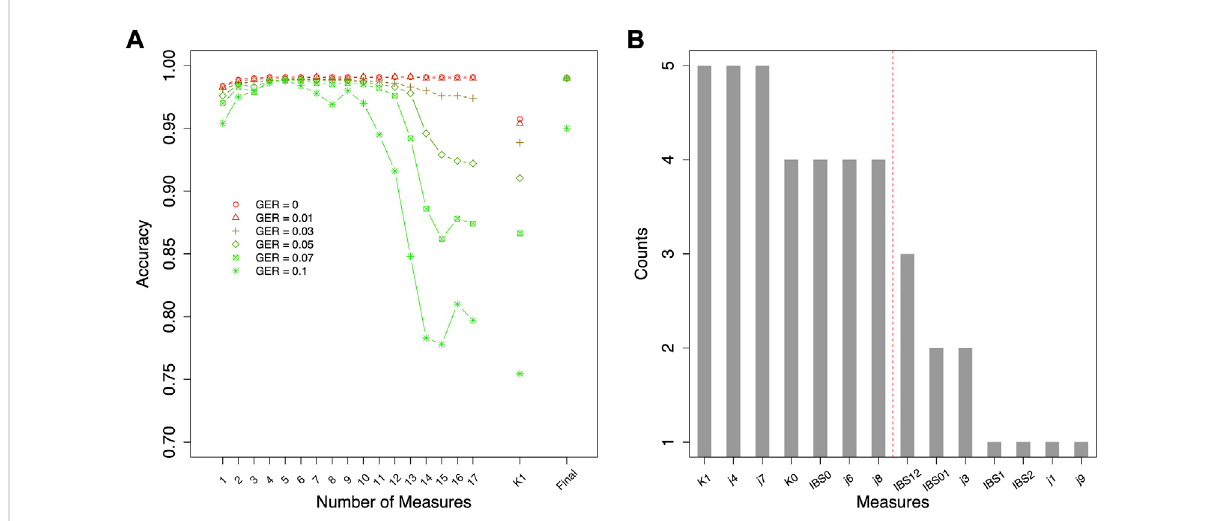
FIGURE 4 Feature selection for classifying relationship degrees using data simulated with various genotyping errors. (A) the accuracies by the forward featureselectionwithvariousgenotypingerrors,inwhichtherankingofthefeaturesfordifferentgenotypingerrorrates(GERs)wasdifferent(e.g.,the fi rst features were K1 and j7 with GER = 0 and 0.1, respectively), and (B) the counts of the commonly selected features across all genotyping errors (e.g., K1 was selected in the feature selections with all six genotyping errors). The features on the left of the red dash line were selected as fi